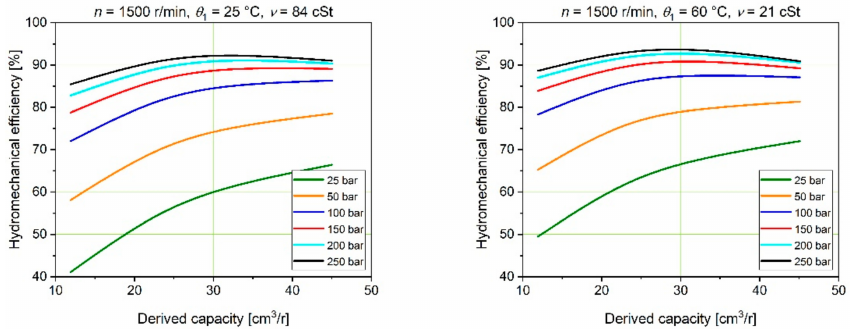
Figure 15. Hydromechanical efficiency of an axial piston pump as a function of derived capacity with six constant pressures. The four-calculation-point efficiency curves have been smoothed with